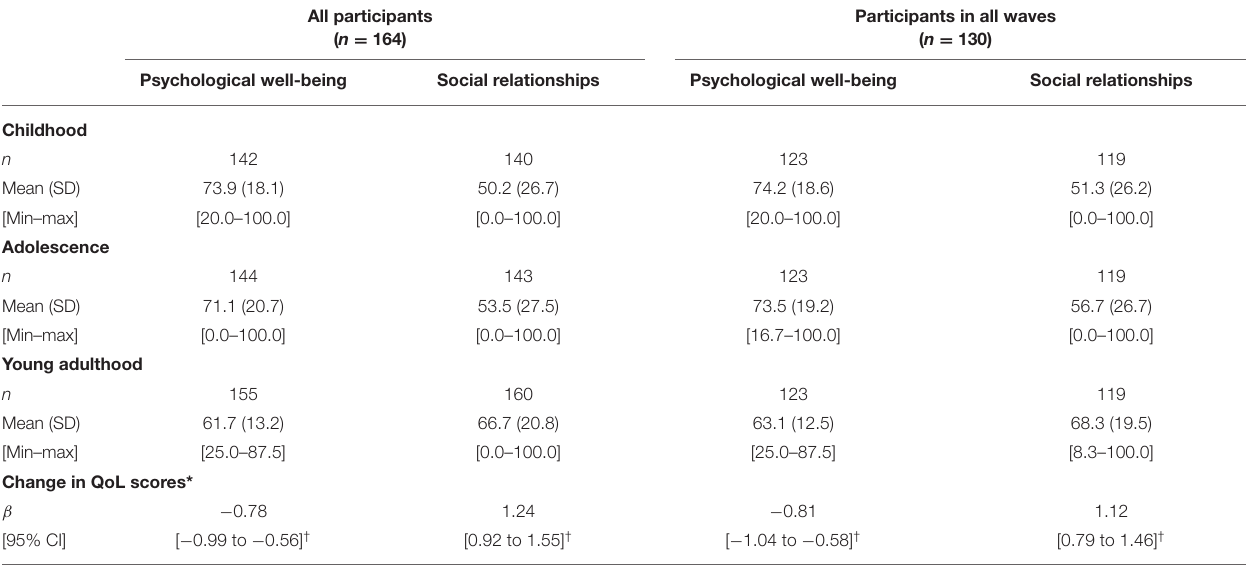
Participants in all waves ( n = 130)